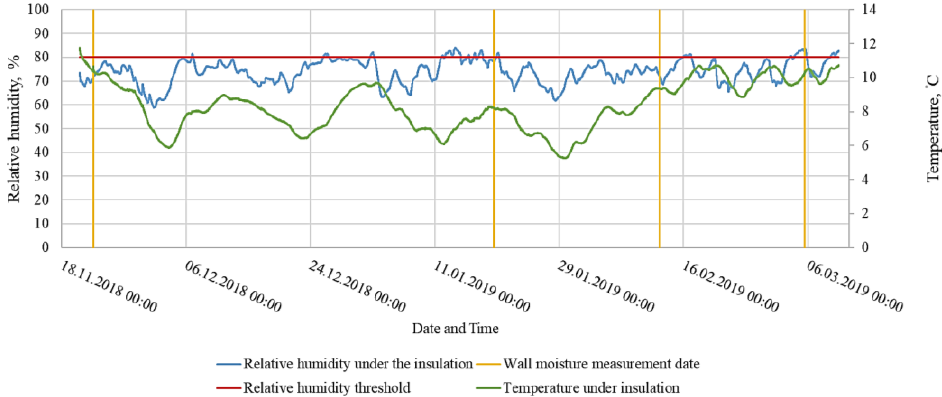
Fig. 12. Relative humidity in the insulation